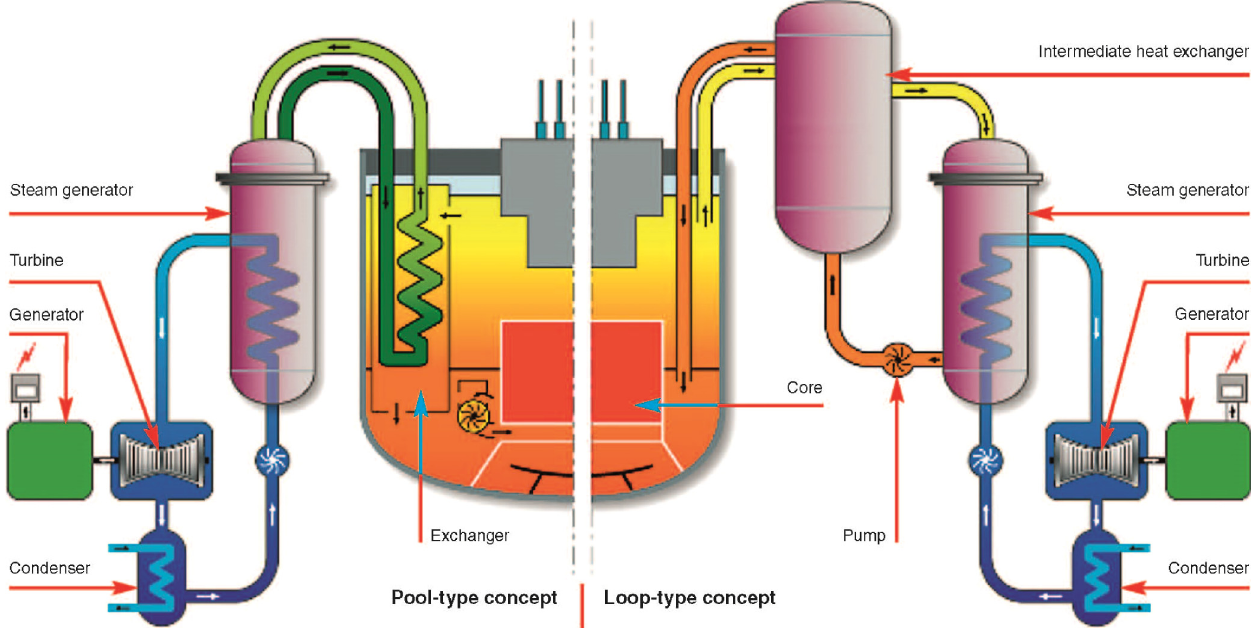
Fig. 9. Functional diagram of the pool-type/loop-type design nuclear supply system [24].